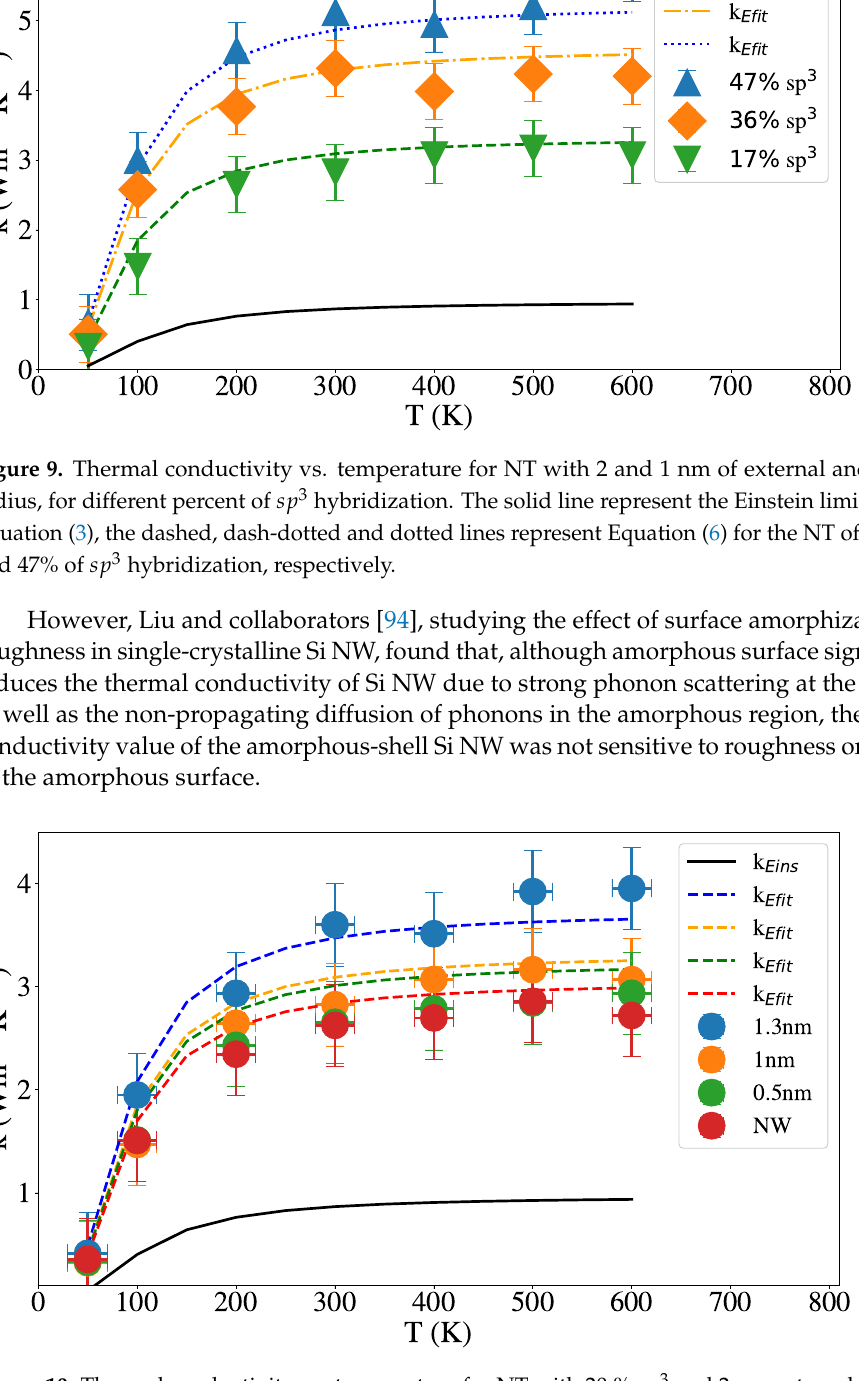
Figure 10. Thermal conductivity vs. temperature for NT with 20 % sp 3 and 2 nm external radius for different internal radii. NW results are also